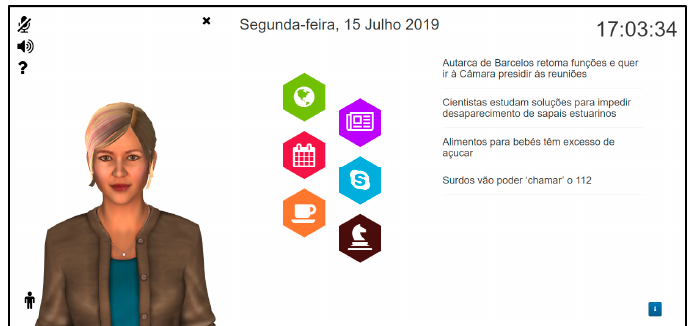
Figure 1. CaMeLi Figure 1. CaMeLi dashboard.